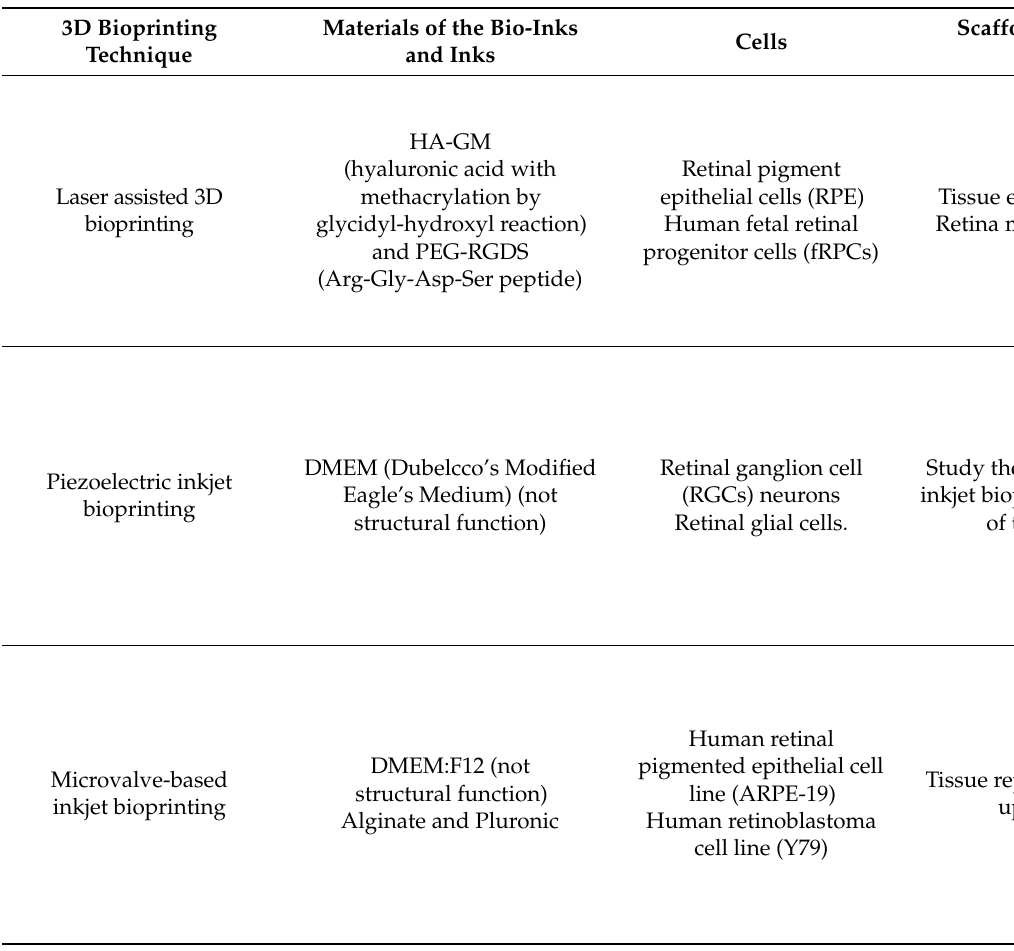
Table 2. Current studies of 3D bioprinting for retina tissue